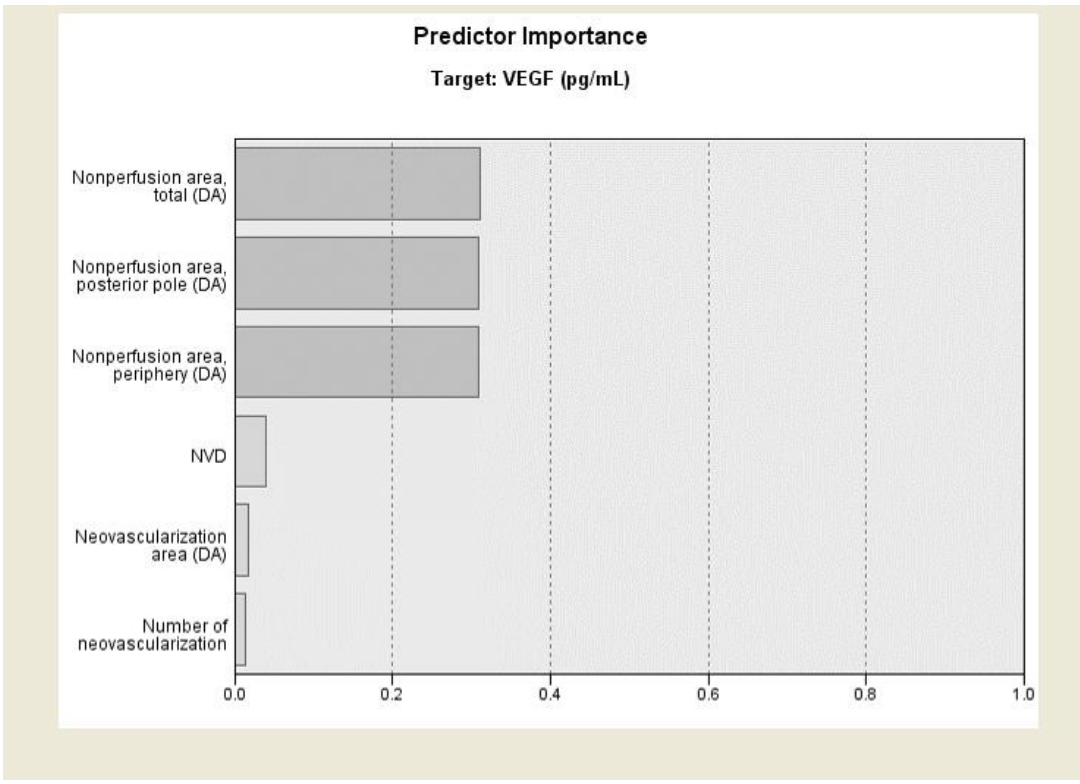
Figure 2. Predictive importance of each angiographic parameter to vascular endothelial growth factor. Automatic linear modelling demonstrated that the total, posterior polar, and peripheral retina NP areas were the most important predictors of aqueous VEGF levels.